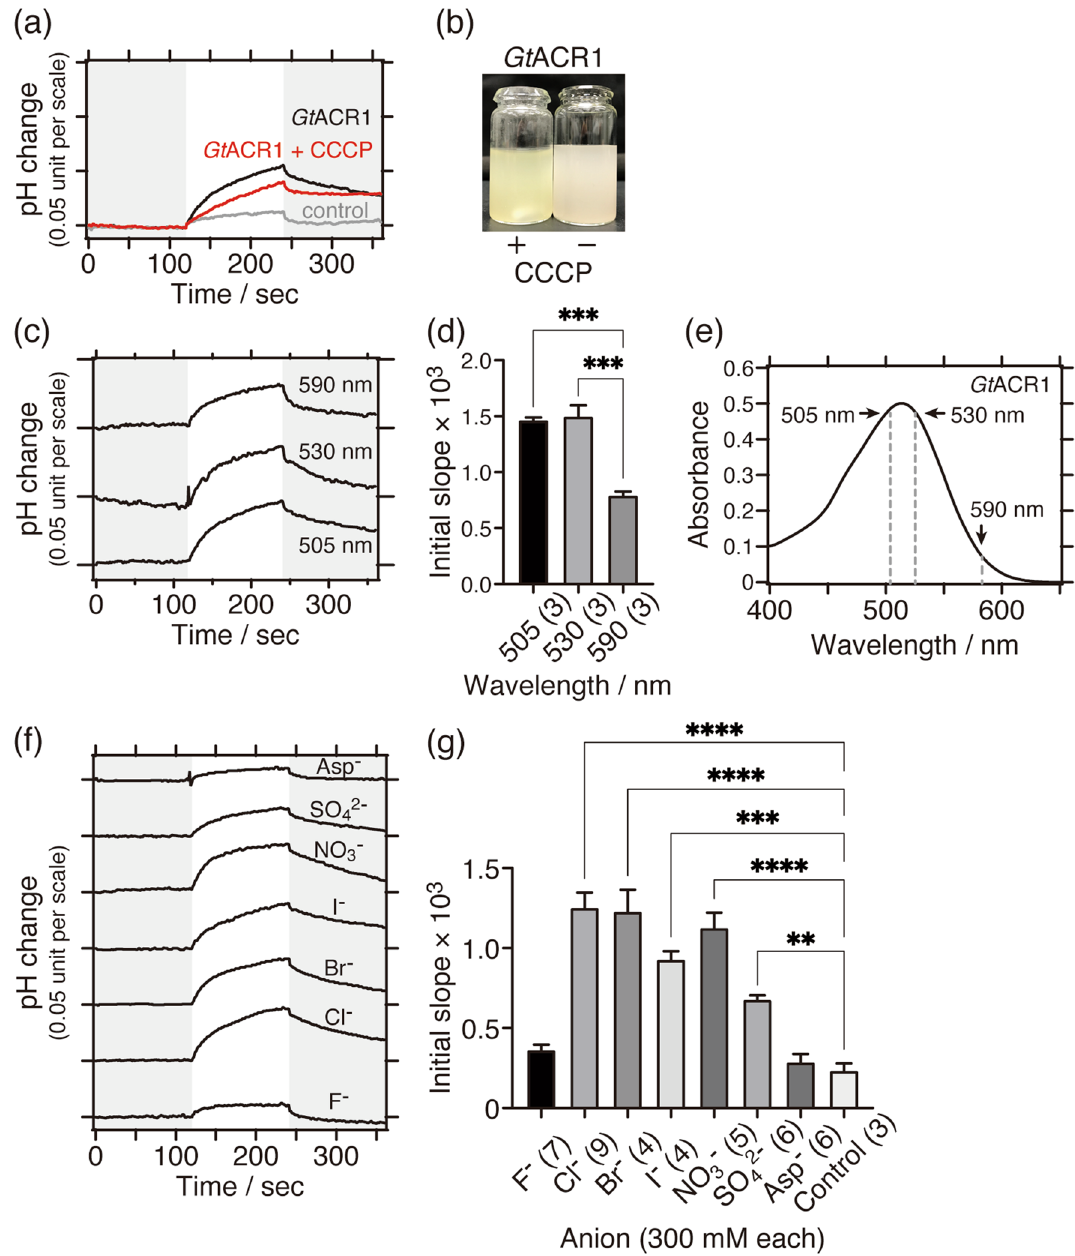
Figure 2. Anion transport activity of Gt ACR1 measured using the pH electrode method. ( a ) Comparisons of Cl − transport activities in the absence (black line) or presence of 10 μM CCCP (red line); the negative control (grey line) was yeast cells without integration of the Gt ACR1 gene. 530 nm LED light (10 mW/cm 2 ) was illuminated for 2 min as shown on a white background. ( b ) The color of pigmented yeast cell suspension expressing Gt ACR1 changed from pink to yellow by adding 10 μM CCCP. ( c ) Comparisons of Cl − transport activities at various excitation light wavelengths (10 mW/cm 2 ). LED lights were illuminated for 2 min as shown on a white background. ( d ) Statistical comparisons of Cl − transport activities at various excitation light wavelengths. Data are reported as means and S.E.M.; the numbers in parentheses indicate the number of independent experiments. One-way ANOVA followed by Tukey’s test was performed ( p value; *** < 0.0006). ( e ) Visible absorption spectrum of purified Gt ACR1 suspended in 10 mM MOPS (pH 7) buffer containing 1 M NaCl and 0.05% n -Dodecyl-β-D-maltoside (DDM). ( f ) Comparisons of anion-dependent transport activities. 530 nm LED light (10 mW/cm 2 ) was illuminated for 2 min as shown on a white background. ( g ) Statistical comparisons of anion-dependent transport activities. Data are reported as means and S.E.M.; the numbers in parentheses indicate the number of independent experiments. One-way ANOVA followed by Dunnett’s test was performed ( p values; **** < 0.0001, *** 0.0001, ** 0.0084). The negative control was yeast cells without integration of the Gt ACR1 gene resuspended in 300 mM